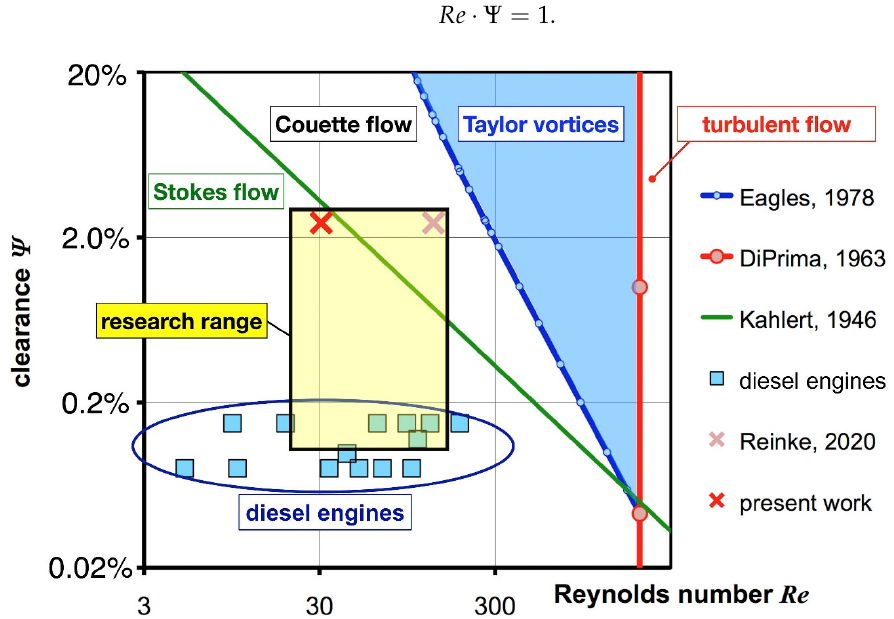
Figure 6. Stability diagram of the Taylor–Couette flow developed from Reinke et al. [26].